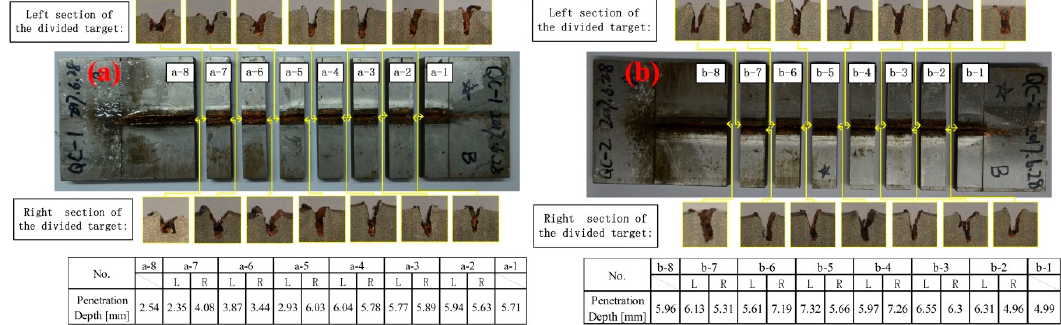
Figure 8. Penetration depth of shaped charges: ( a ) LSC; ( b ) BLSC.